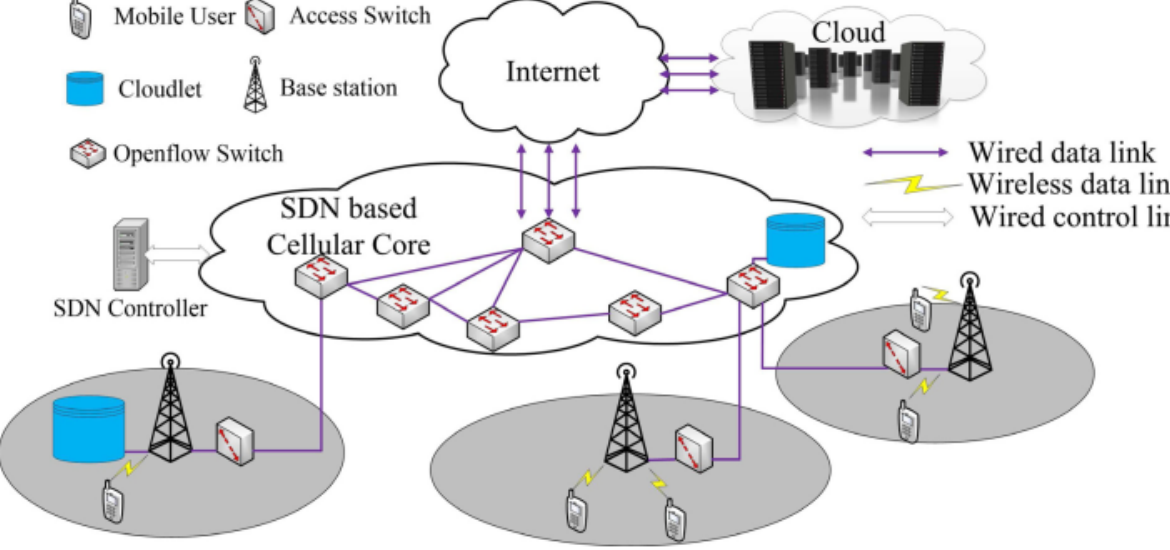
Figure 3. SDN Based Mobile Sensors Cloudlet Cloud Network